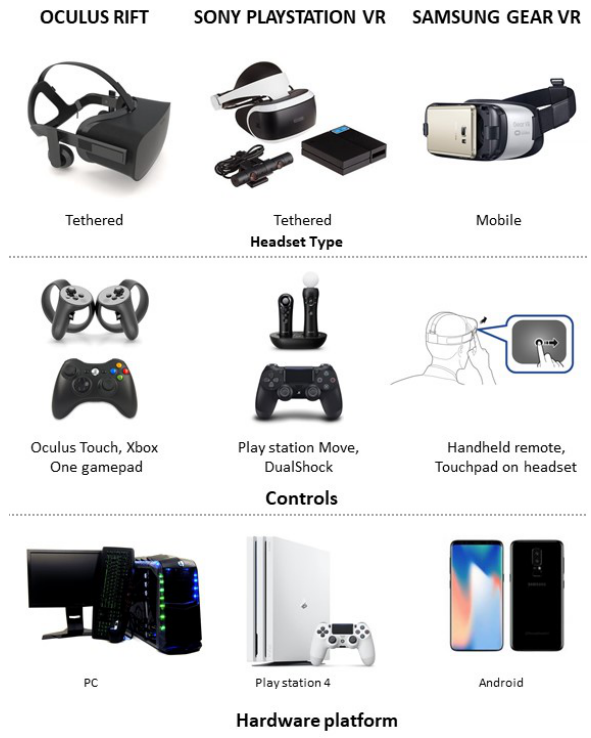
Figure 2. The different type of devices, headset and controls for VR projects.